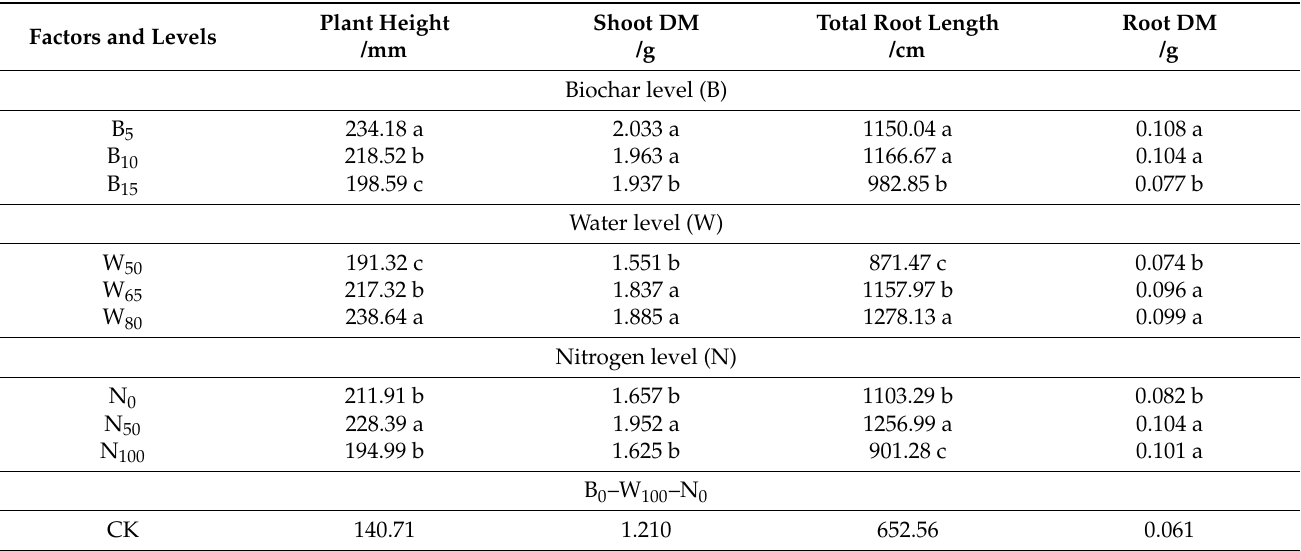
Table 4. The plant height, shoot dry biomass, total root length, and root dry biomass of cucum- ber